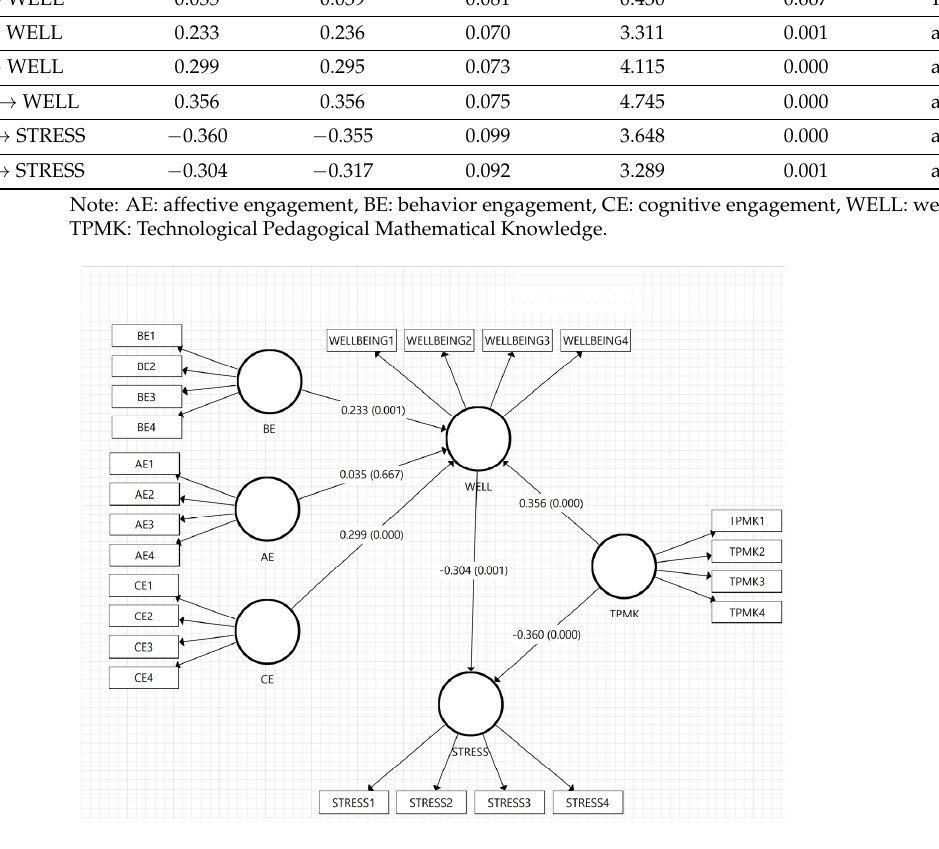
Figure 3. Discovery of structural model analysis with p -value and T statistics. Note: AE: affective engagement, BE: behavior engagement, CE: cognitive engagement, WELL: well-being, and TPMK: Technological Pedagogical Mathematical Knowledge. Table 6. Results of initial hypothesis testing.